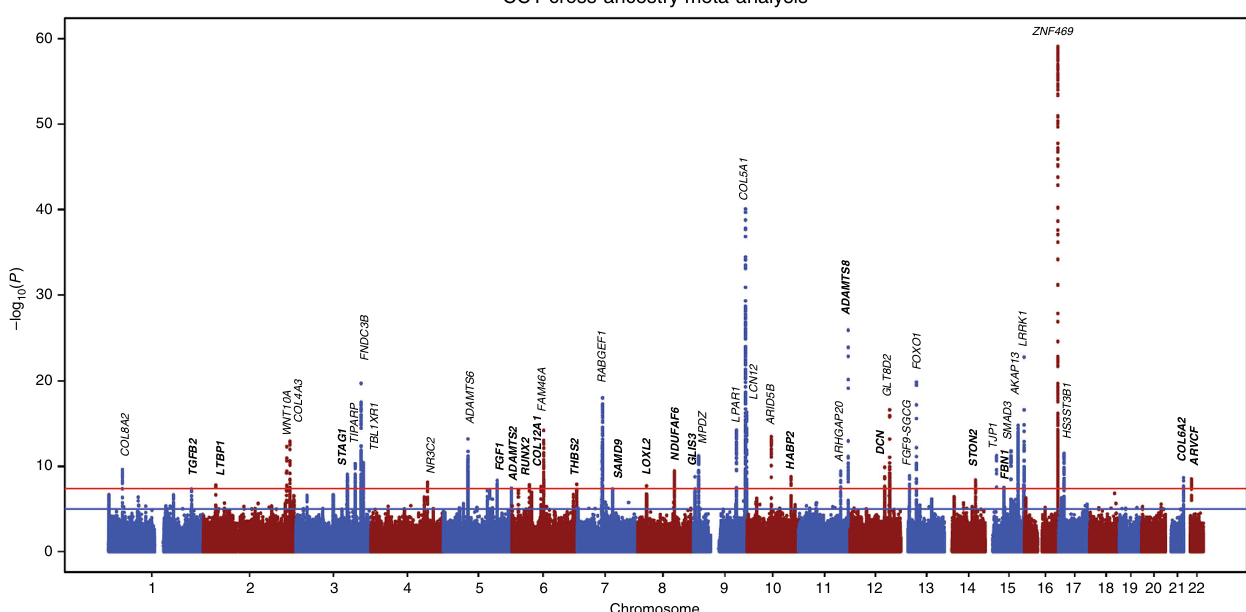
Fig. 1 Manhattan plot of CCT in the cross-ancestry meta-analysis. Manhattan plot of the GWAS meta-analysis for CCT in the cross-ancestry analysis ( n = 25,910). The plot shows − log10-transformed P -values for all SNPs. The red horizontal line represents the genome-wide signi fi cance threshold of P < 5.0 × 10 − 8 ; the blue horizontal line indicates a P -value of 1 × 10 − 5 . Loci are annotated to the nearest gene as in Tables 1 and 2. New loci are in